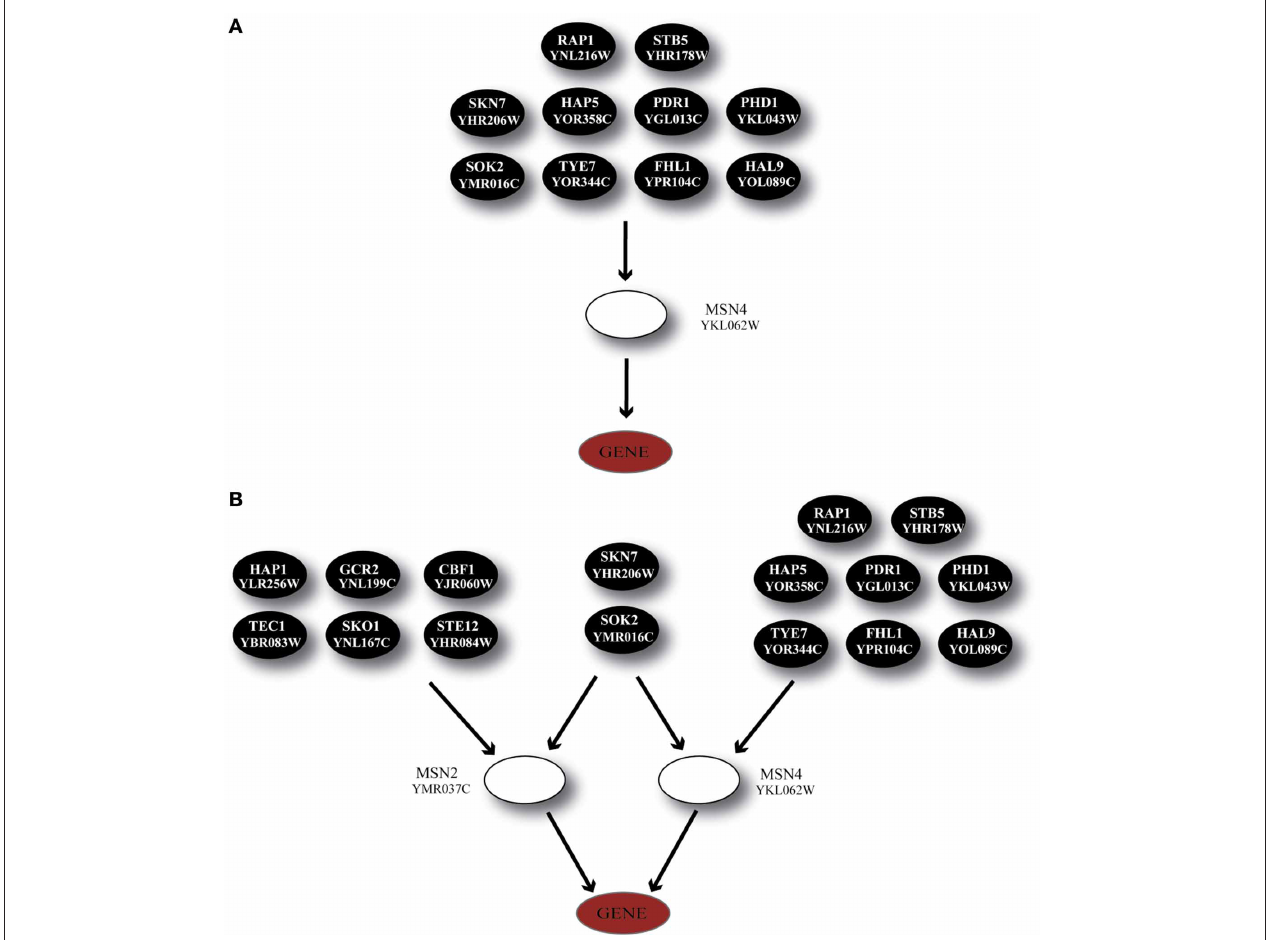
FIGURE 9 | Regulatory cascades containing the TF MSN4 as the GRAM-identified regulator. (A) Regulatory cascade where only MSN4 is considered as a regulator. (B) Regulatory cascade where MSN4 and MSN2 are considered as regulators of the target